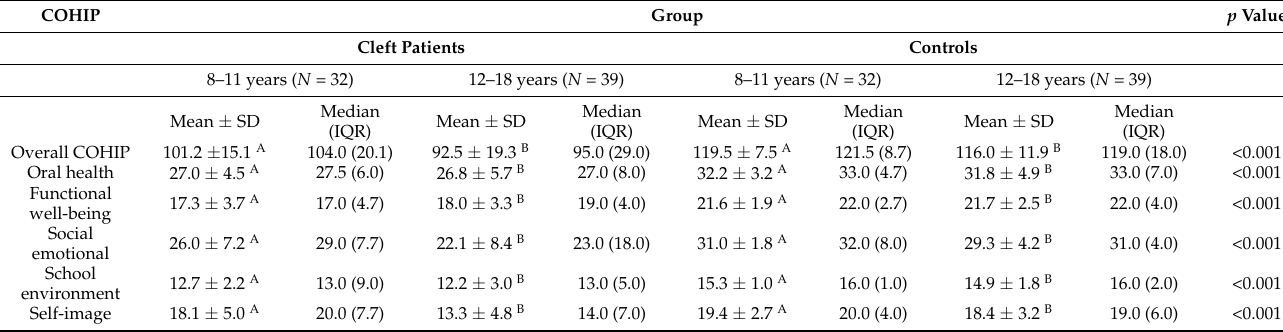
Table 3. Overall and subscale COHIP scores by age and